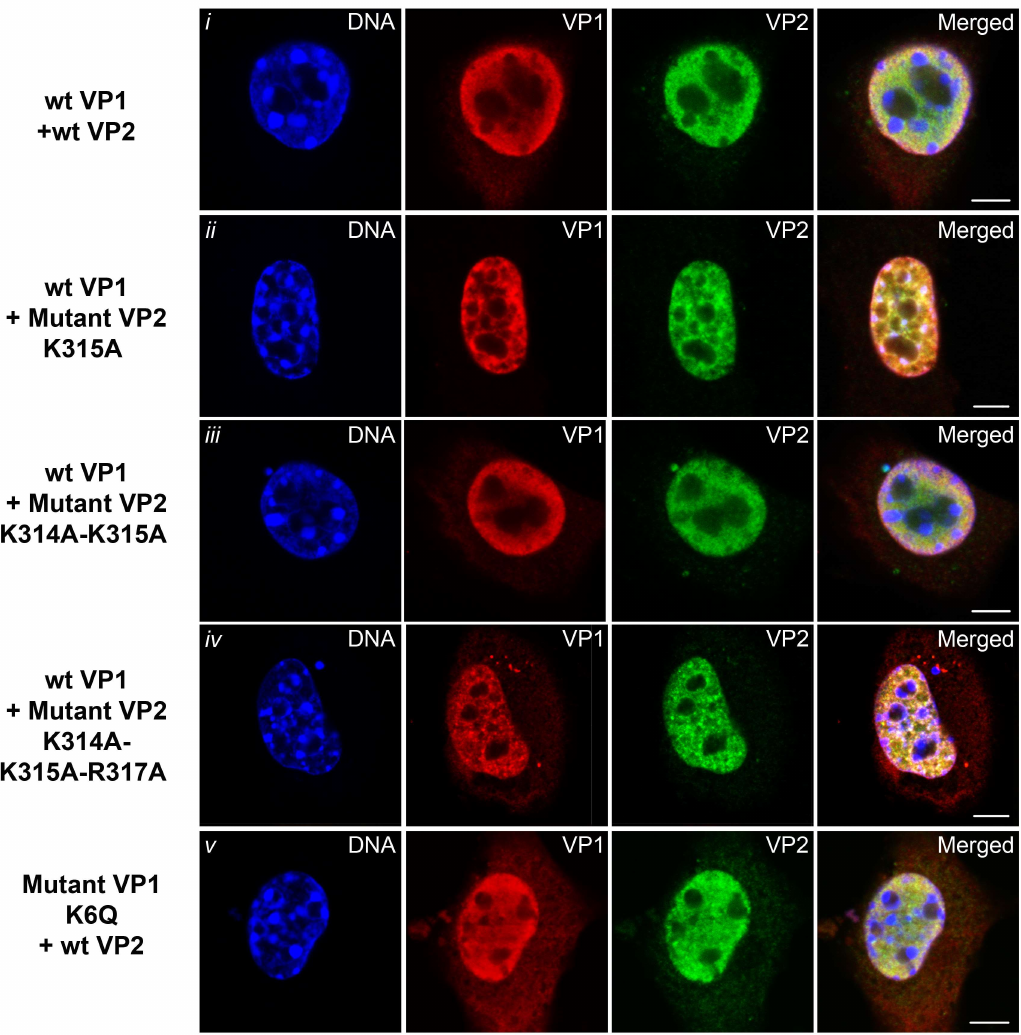
Figure 9. Nuclear entry of wt and mutant variants of the VP1 and VP2 proteins. Confocal sections of 3T3 cells co-expressing combinations of wt VP1 and wt VP2 ( i ) or wt VP1 and mutated variants of VP2 ( ii – iv ) or wt VP2 with the mutated variant of the VP1 ( v ). Cells were fixed at 24 hpt and stained with antibodies against VP1 (red) and VP2 (green). DNA was stained by DAPI (blue). Bars 5 µ